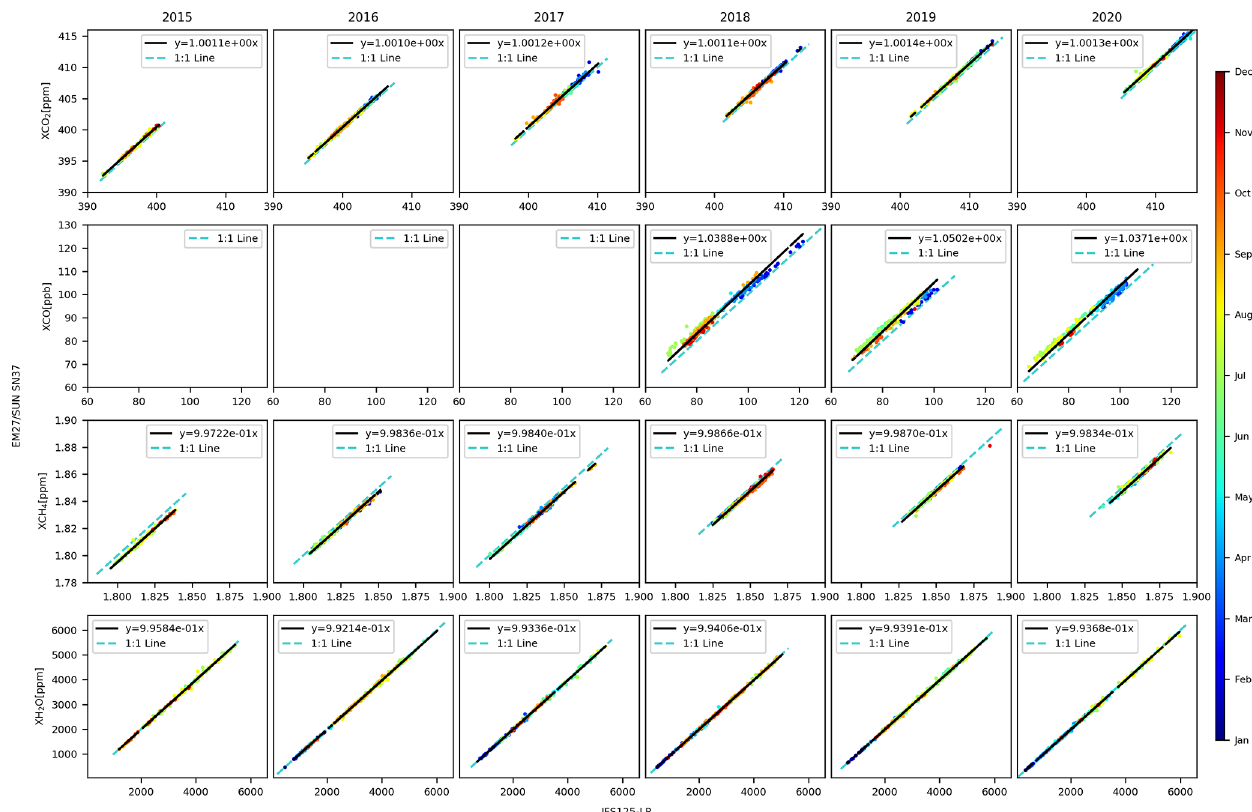
Figure 23. Correlations between the species: XCO 2 , XCO, XCH 4 and XH 2 O retrieved with the COCCON reference instrument and the TCCON instrument in low-resolution measurement mode in each row (top-down), respectively, treated separately by year from 2015 to 2020 in each column for each